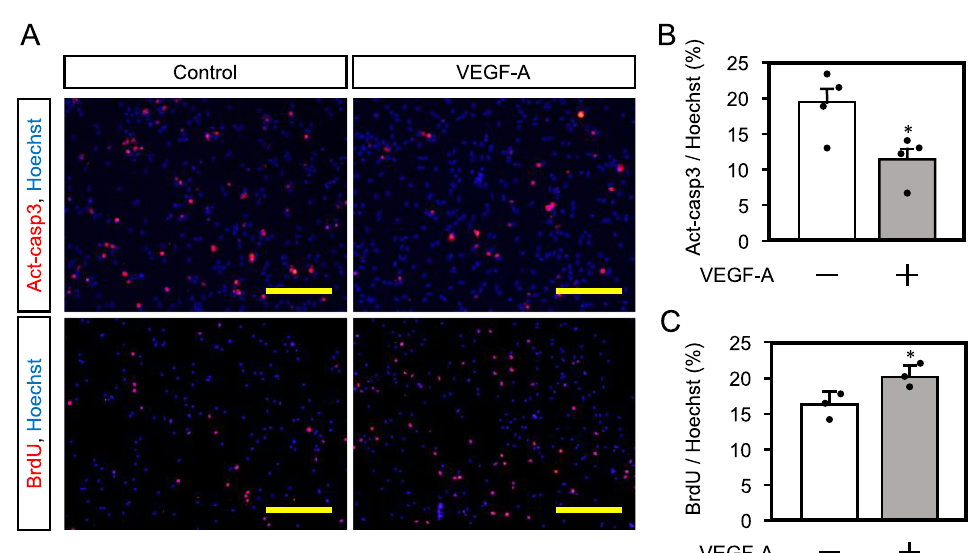
Fig. 5. VEGF-A suppresses NSPC apoptosis while promotes NSPC growth. A Detection of apoptotic (upper panels) and proliferated (lower panels) NSPCs derived from E14.5 cortex in the absence or the presence of 10 ng/ml of VEGF-A under the normoxic condition. Scale bar Quantification of apoptotic NSPCs (mean Quantification of proliferated NSPCs (mean